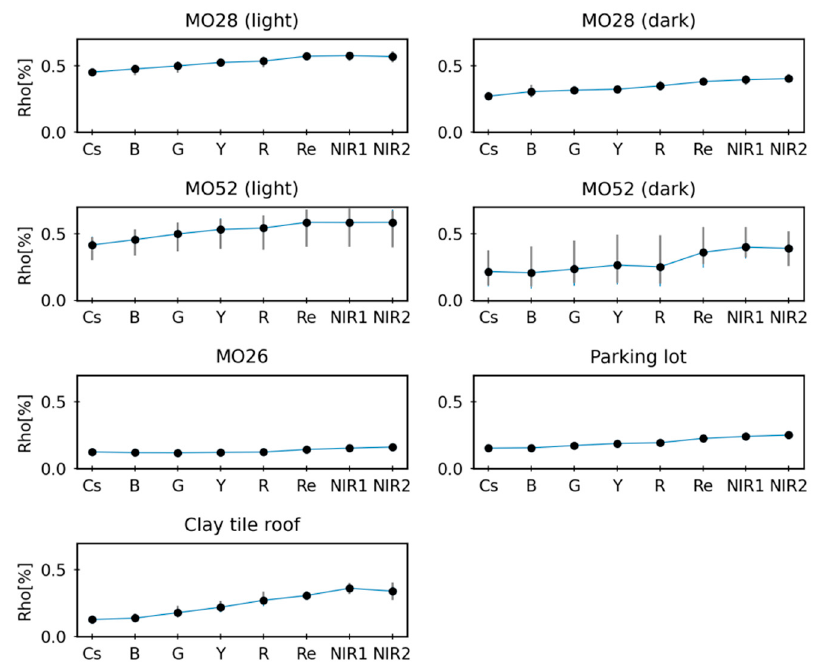
Figure 6. Spectral signature computed for each